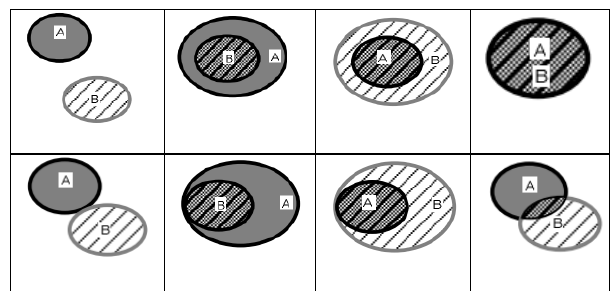
Figure 1. Spatial relations between two